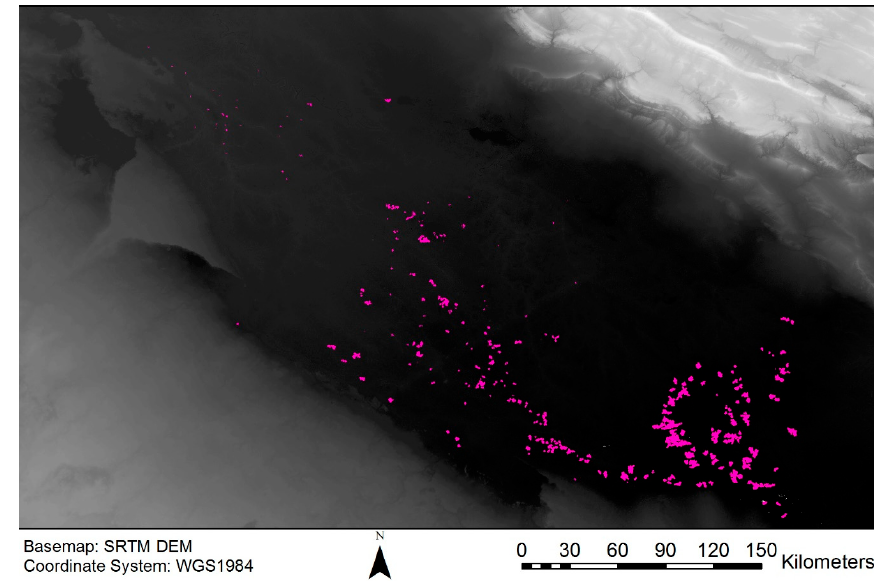
Figure 7. More than 6000 hollow way segments around 334 sites in Southern Mesopotamia were identified by this survey. A Google Earth (.kmz) file of these hollow ways is available in the Supplementary Materials.